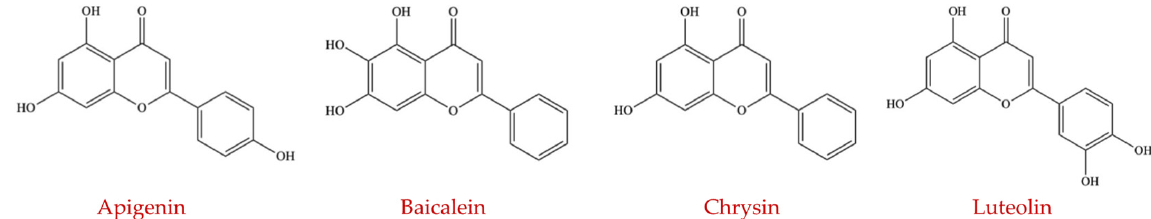
Figure 4. Chemical structures of flavones (apigenin, baicalein, chrysin, and luteolin) (self-generated).